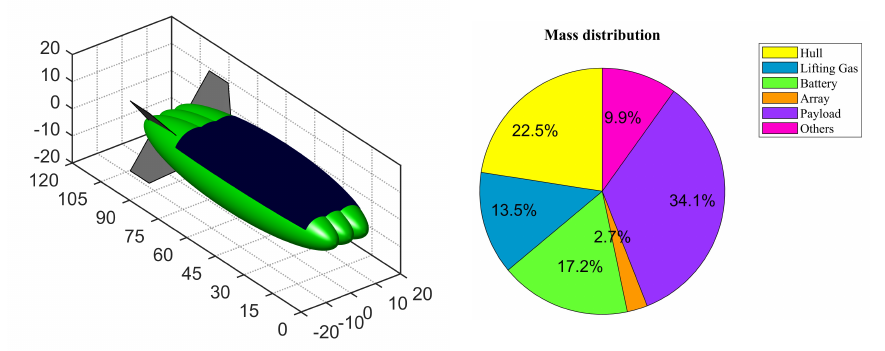
Figure 12. Fully electric multi-lobed